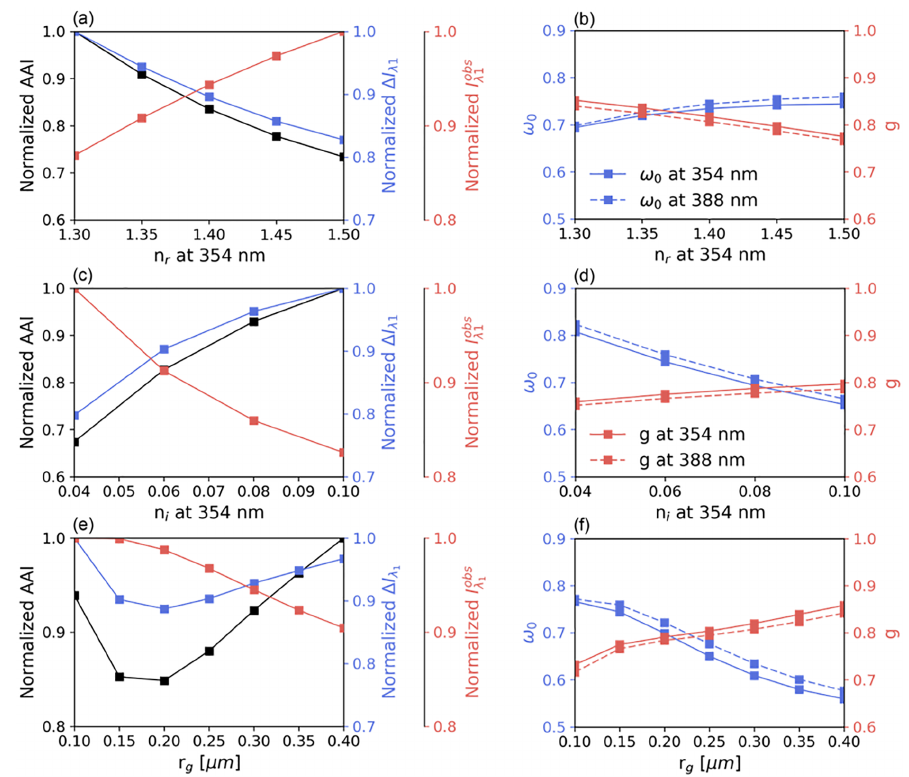
Figure 3. AAI sensitivity to microphysical parameters n i (a, b) , n r (c, d) and r g (e, f) . The left panels (a, c, e) show the sensitivity of the normalized AAI (black), the normalized (cid:49)I λ (blue) and the normalized I obs (red). The right panels (b, d, f) show ω 0 (blue) and g (red) at λ 1 1 wavelengths 354 (solid line) and 388nm (dashed line), respectively.